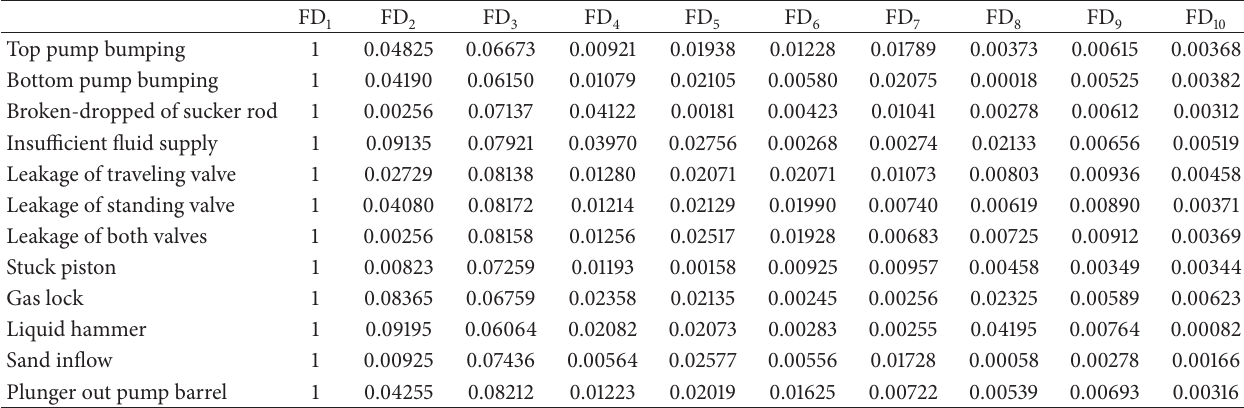
Table 1: Normalized Fourier Descriptors of 12 typical fault indicator cards.